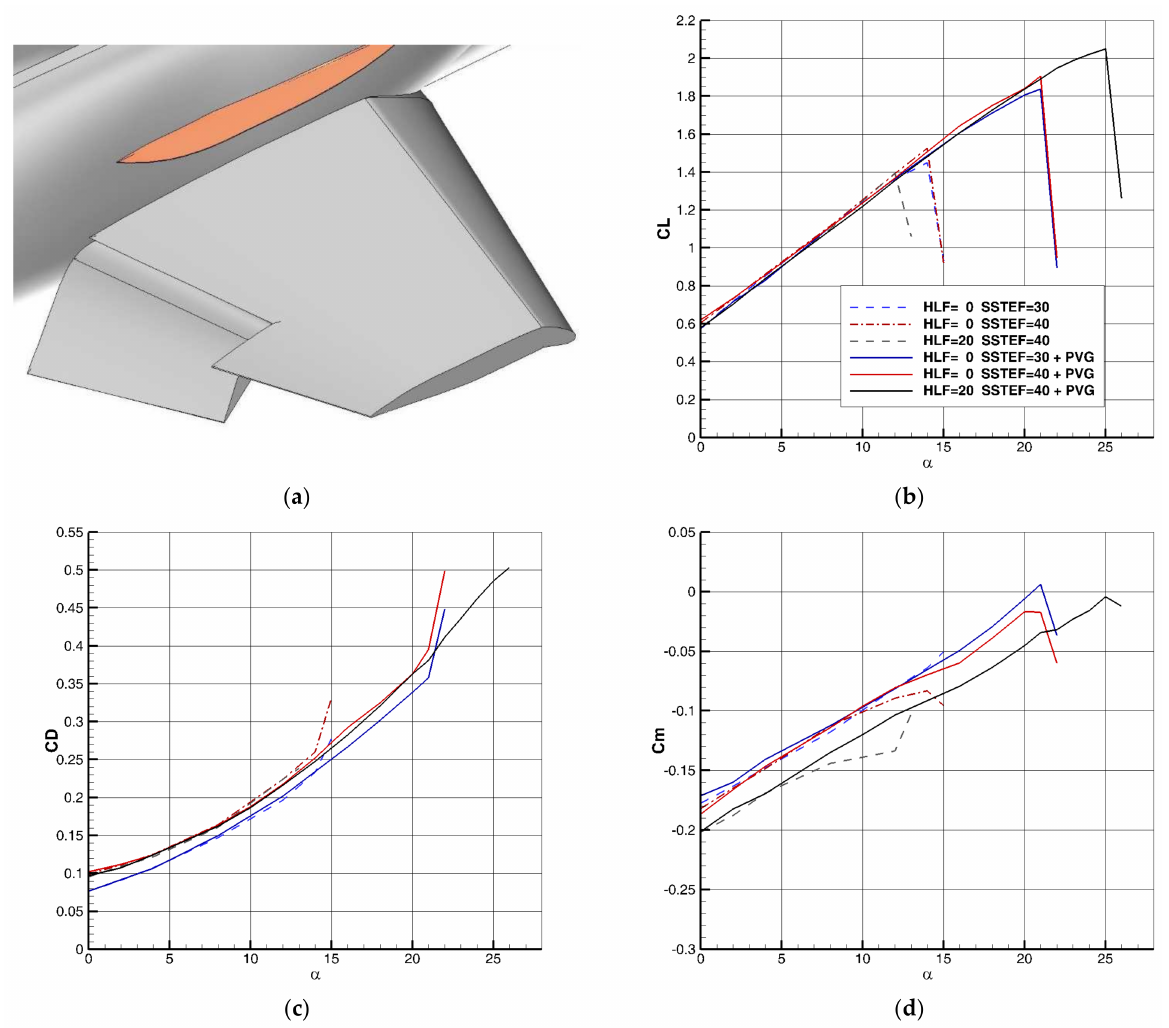
Figure 17. Effect of PVG on the HLF and SSTF configurations of the wing-body in V = 60 m/s: ( a ) the